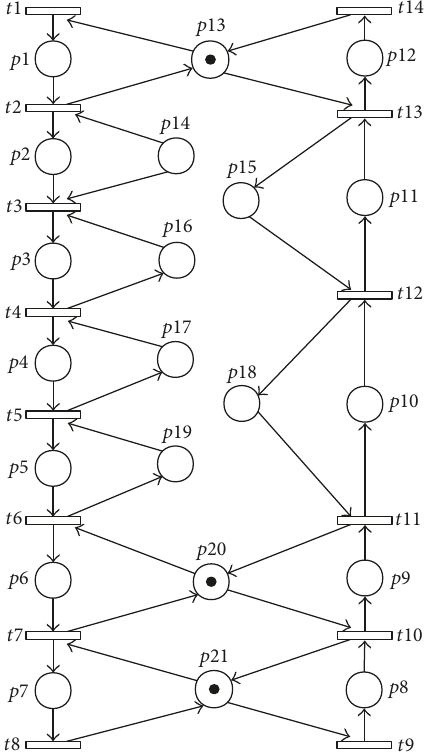
Figure 13: An example of a four-step look-ahead structure derived from Figure